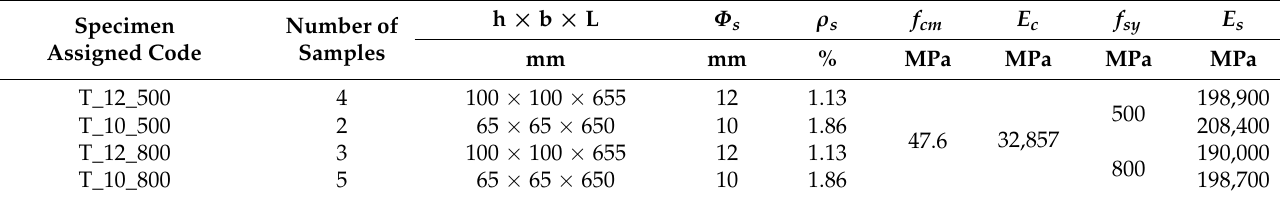
Table 1. Geometrical and mechanical characteristics of the